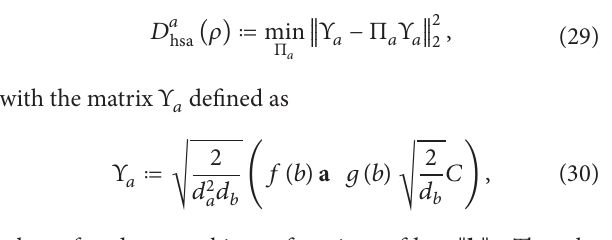
Figure 1: The points are the values of the ameliorated Hilbert- Schmidt quantum discord of Werner states computed numerically using (32). The lines are the corresponding values of the AHSD plotted via the analytical formula: 𝐷 𝑎 hsa (𝜌 𝑤 ) = 𝑑 𝑎 𝐷 𝑎 hs (𝜌 𝑤 ) = (𝑑 𝑎 𝑤 − − 1)(𝑑 + 1) 2 ) . Due to the symmetry of 𝜌 𝑤 , here 𝐷 𝑎 1) 2 /((𝑑 𝑎 𝑎 𝐷 𝑏 (𝜌 𝑤 ) . In the inset the difference between the times taken by hsa the two methods to compute the AHSD for a fixed value of 𝑑 𝑎 is shown. We see clearly here that our optimized algorithm gives an exponential speedup against the brute force calculation of Bloch’s vectors and correlation